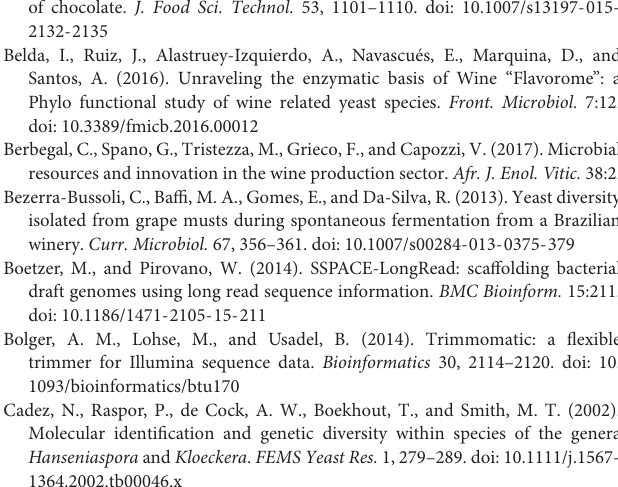
FIGURE S1 | Heatmap of the number of species-specific genes associated with selected PFAM domains. The heatmap displays the number of species-specific genes associated with biotechnologically relevant PFAM domains. Dark blue indicates high values. Light blue low values. Unity based normalization is applied to the columns of the heatmap (i.e., the domains) to facilitate the comparison. TABLE S1 | Annotation of heterozygous sites and availability of raw sequencing data. Full names of all the Hanseniaspora species included in this study are reported in the first column. In the second column, “yes” indicates that annotation of heterozygous sites is provided in the reference assembly, a “no” indicates that this information is not available. Availability of raw sequencing data (yes available, no not available) are reported in the 3rd column. TABLES S2–S4 | Over and under representation of protein PFAM domains in the 3 H. uvarum genomes assembled in this study. Names of annotated PFAM domains are reported in the first column. The 2nd and 3rd column report, respectively the total number of occurrences of each domain, and the total number of annotated PFAM domains identified for that species. The 4th and the 5th column contain the equivalent figures (occurrences each domain and total number of domains annotated) for the H. uvarum pan-genome. p -values for under and over-representation are reported in the 6th and 7th column respectively. TABLE S5 | Occurrence of selected PFAM domains in species-specific genes. Domains are indicated in the rows and species in the